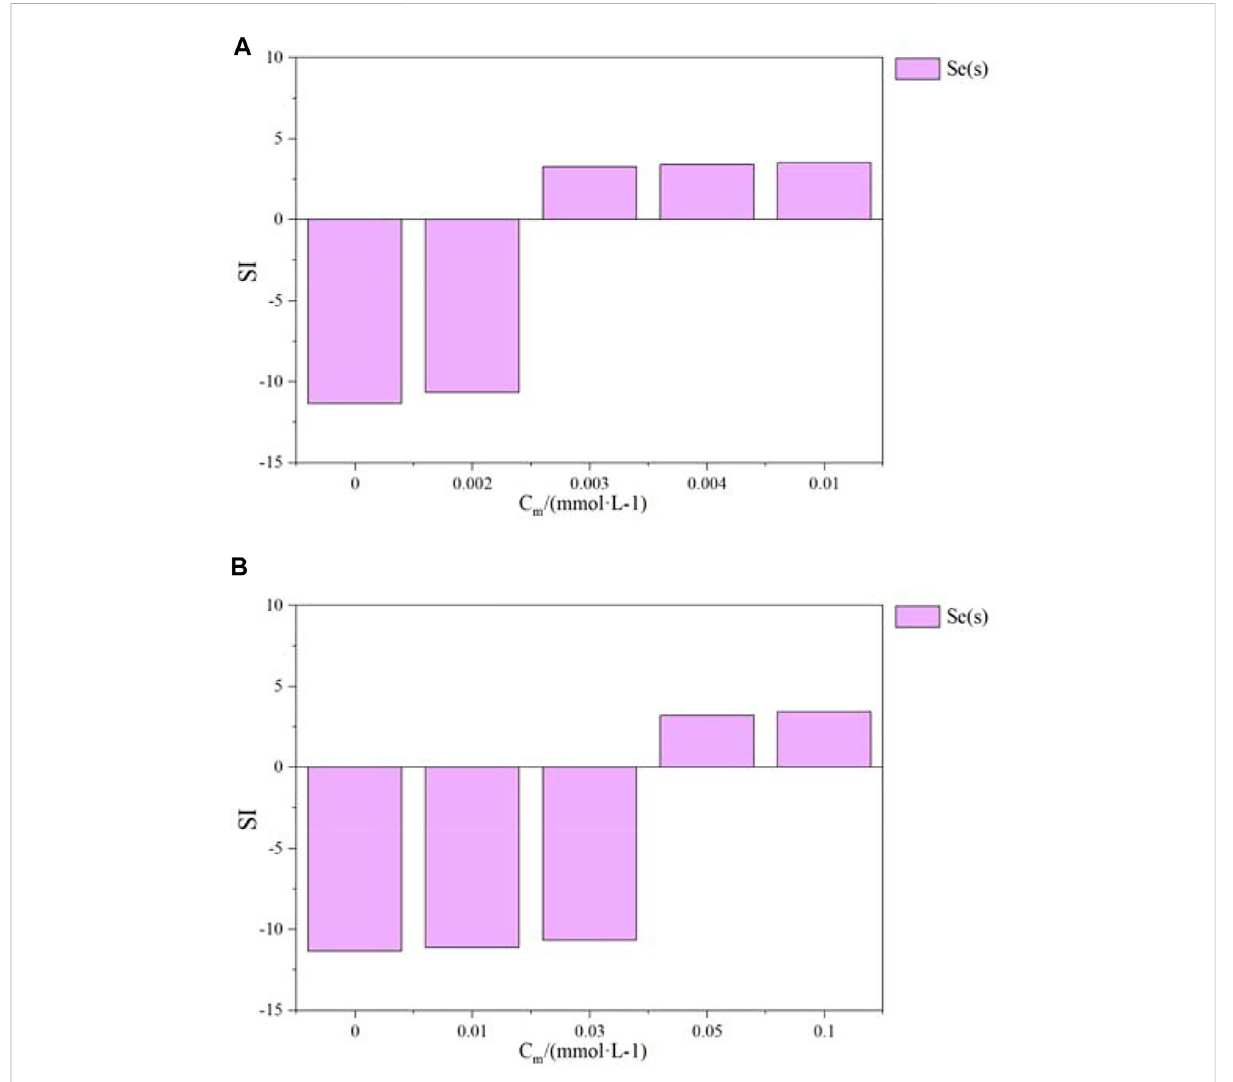
FIGURE 5 Saturation index evolution of the precipitation of Se(s) as a function of pyrite (A) and magnetite (B) .